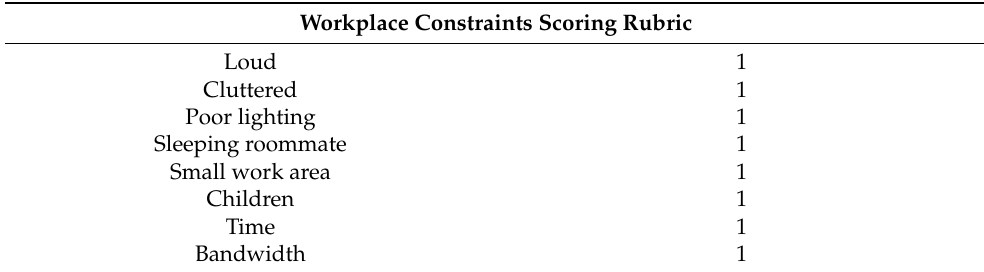
Table A3. Workplace constraints rubric for survey answers. Participants were told to select all that applied, and scores were cumulative based on their selections.